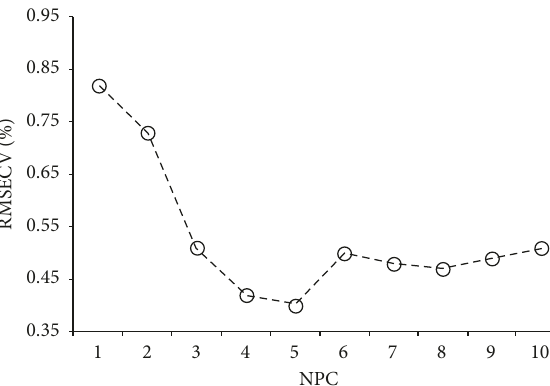
Figure 4: RMSECV-NPC diagram of the PLSR-6 model.